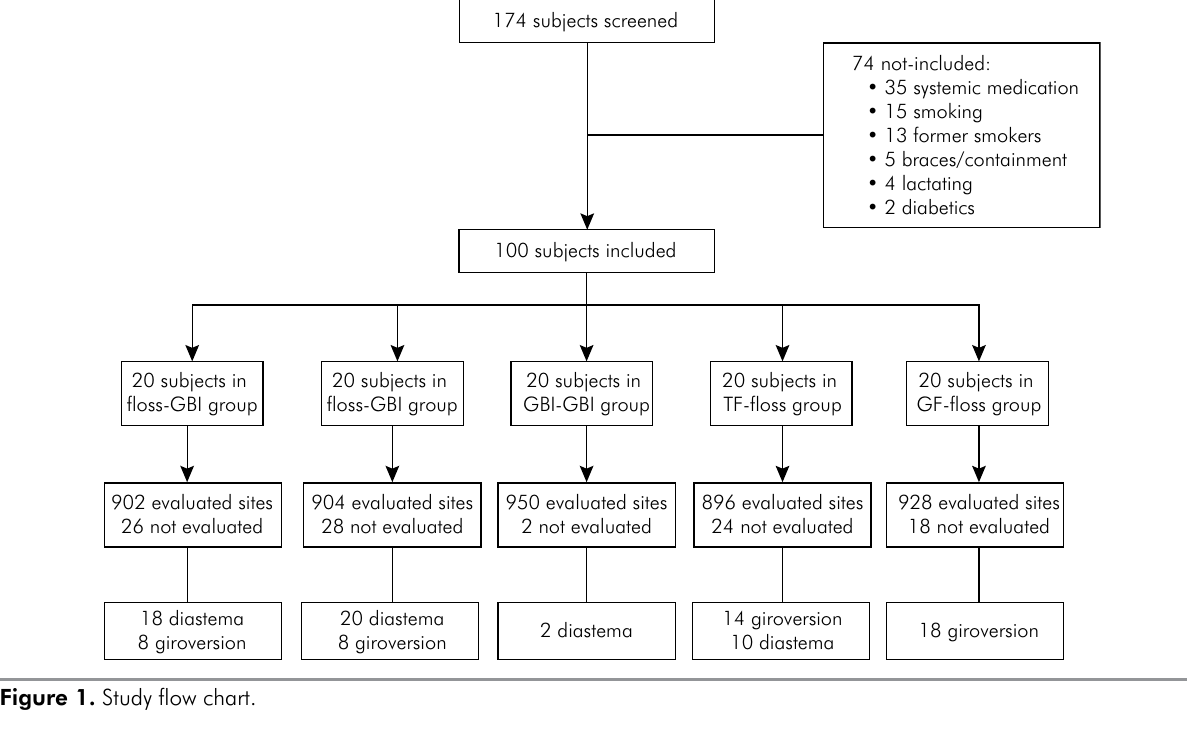
Figure 1. Study flow chart.